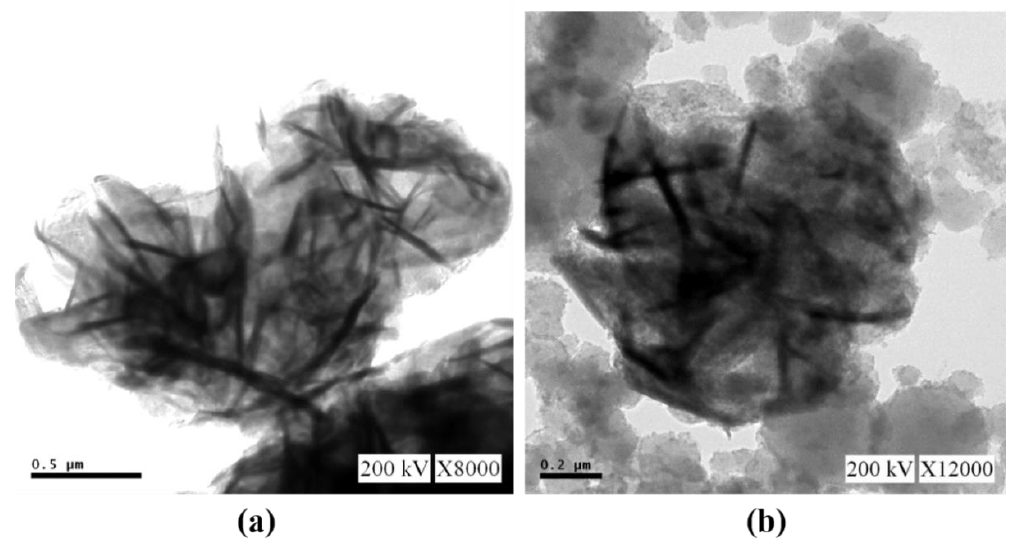
Figure 3. TEM images of ( a ) Flower-like SnS 2 , ( b ) SnS 2 -SiO 2 @α -Fe 2 O 3 nanocomposite.